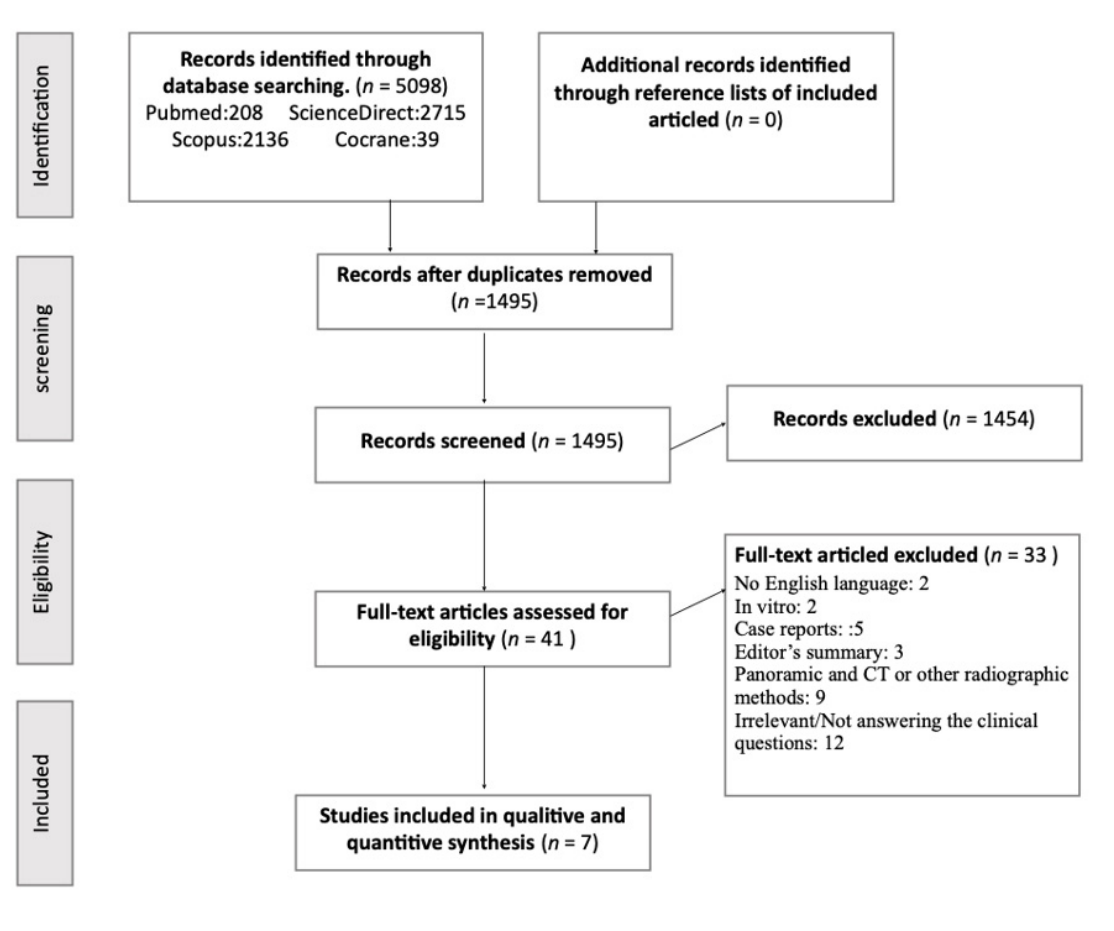
Figure 1. Flow diagram.